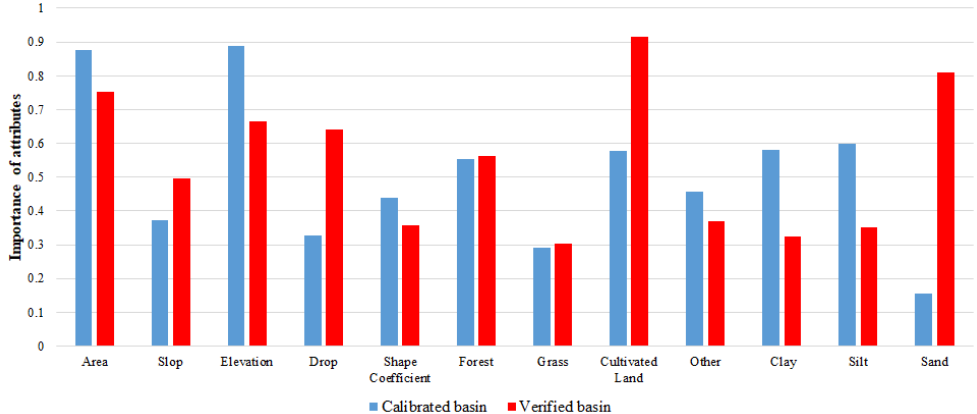
Figure 9. Importance of attributes in RF